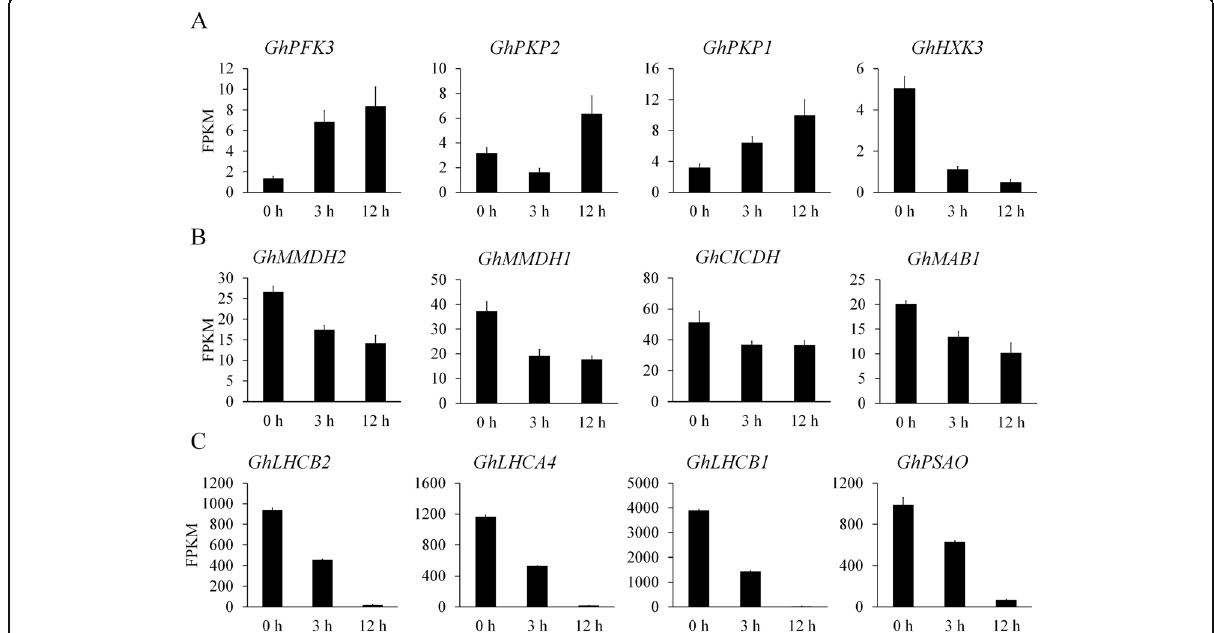
Fig. 3 The expression patterns of functional genes which were involved in energy metabolism. a The expression patterns of genes involved in the glycolysis/gluconeogenesis pathways. b The expression patterns of genes involved in tricarboxylic acid cycle. c The expression patterns of genes involved in